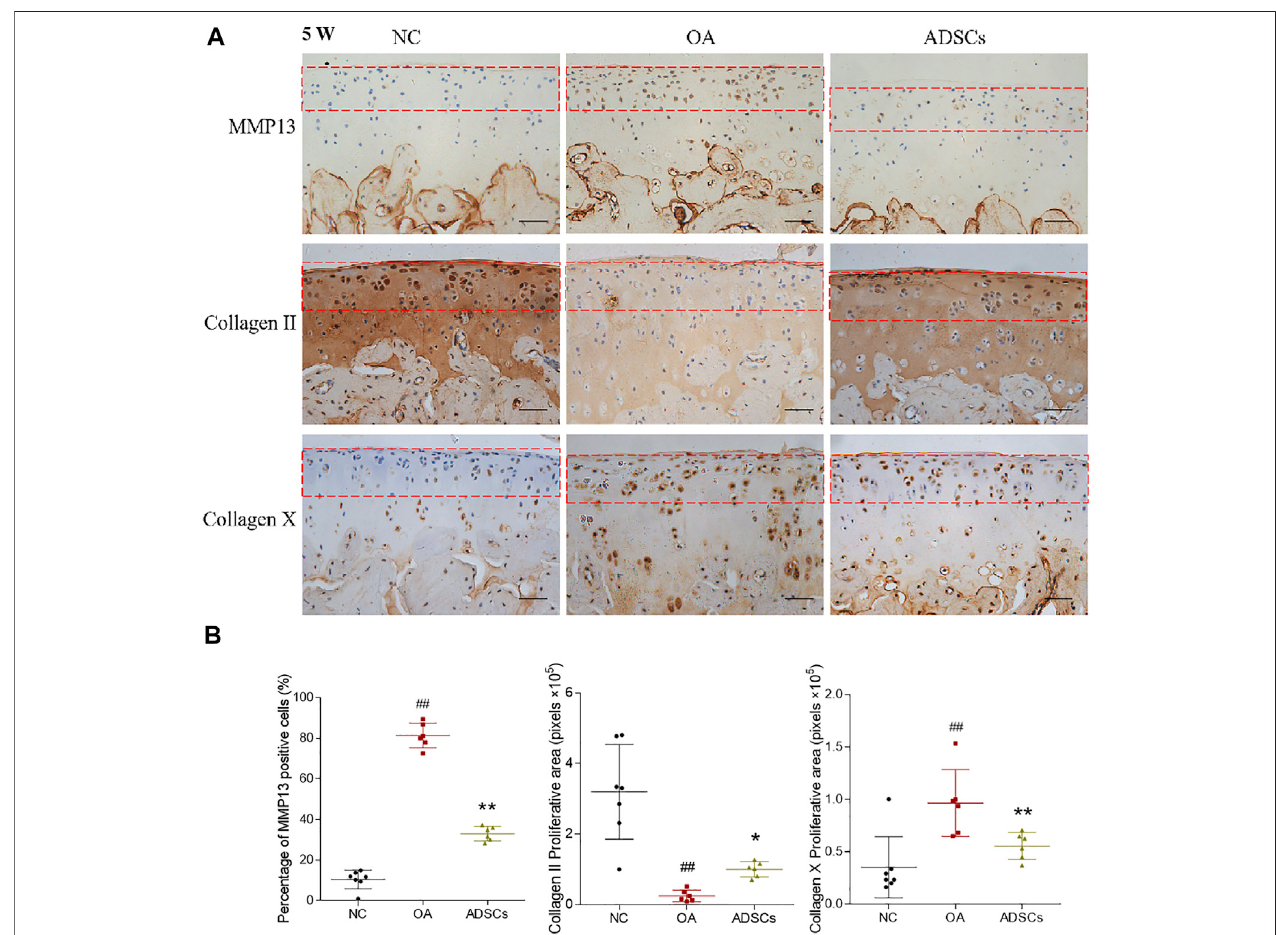
FIGURE3| Effects ofADSCson expressions ofCollagenII,CollagenX and MMP13 onratcartilage. (A) Representativeimmunohistochemical stainingofCollagen II, Collagen X and MMP13 on cartilage at the fi fth week of the experiment (5 W). Red dash box indicates region of interest where the MMP13, Collagen II and Collagen X positive cells were counted. Scale bars = 50 μ m. (B) Positive cell percentages of MMP13 and quantitative measurement of positive area percentage of Collagen II and Collagen X. Values were presented as mean ± SD. N = 6. ## p < 0.01 versus NC group; * p < 0.05 and ** p < 0.01 versus model group.